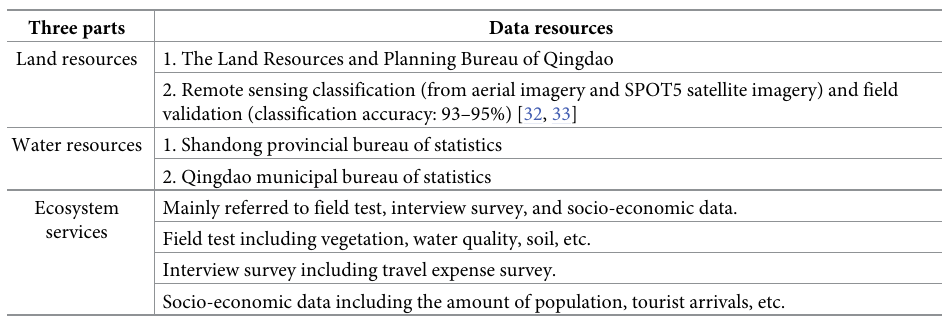
Table 2. Data used and